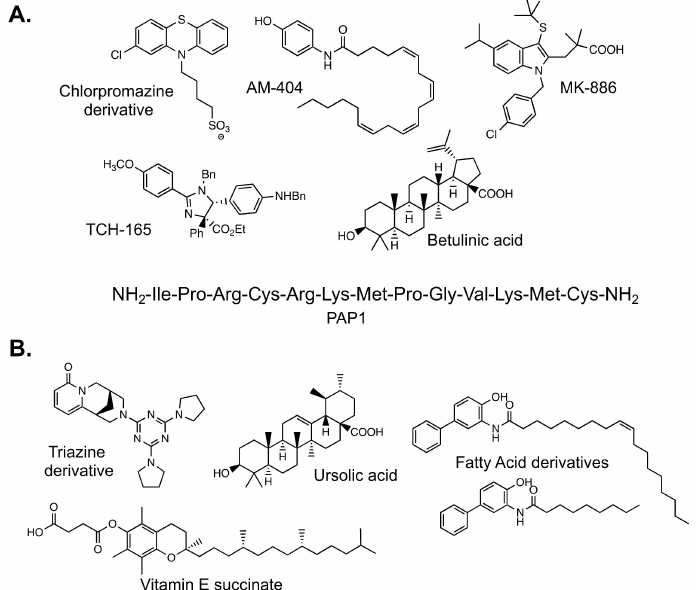
Figure 3. ( A ) Structures of small molecule and peptide stimulators discovered using